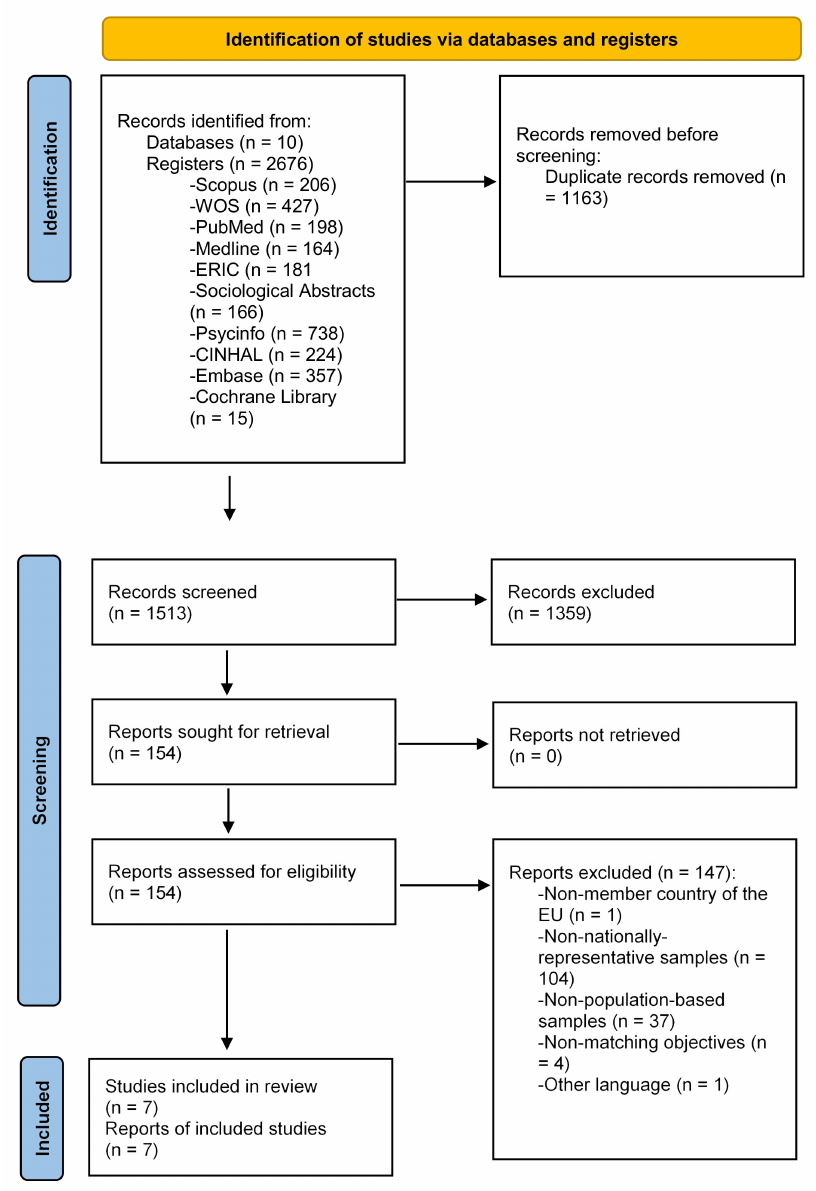
Figure 1. PRISMA flowchart of the study selection